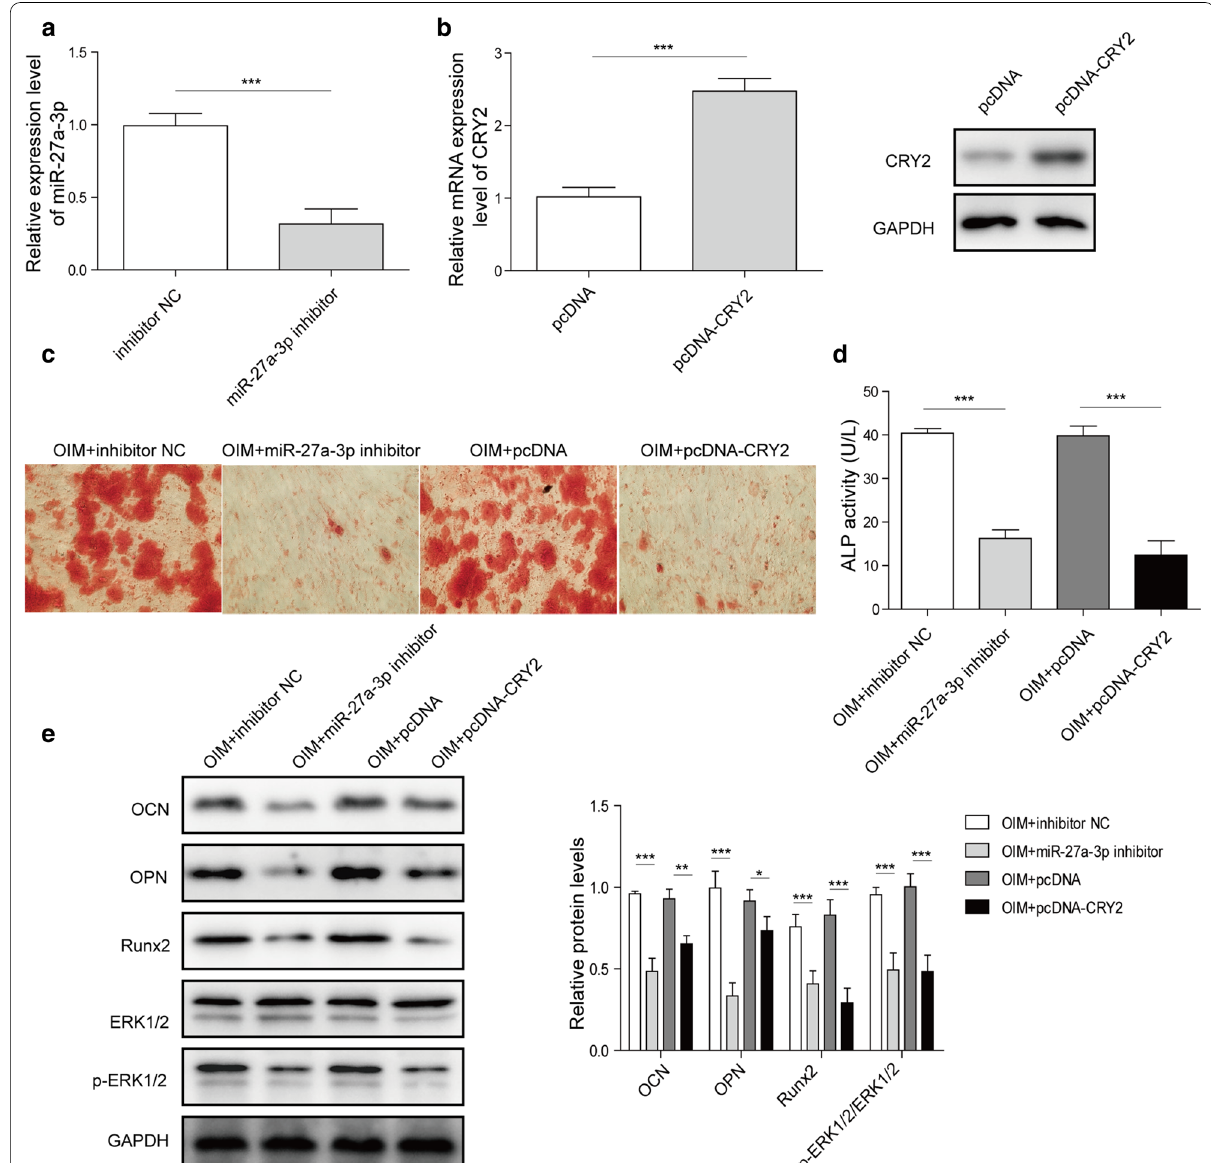
Fig. 2 Knockdown of miR‑27a‑3p and overexpression of CRY2 inhibited ODM. MC3T3‑E1 cells were transfected with miR‑27a‑3p inhibitor or CRY2 overexpression. a RT‑qPCR detected the levels of miR‑27a‑3p. b RT‑qPCR and western blotting examined CRY2 expression. c Alizarin Red staining in MC3T3‑E1 cells. d Detection of ALP activity. e Western blotting analyzed the expression of OCN, OPN and RUNX2. *P < 0.05, **P < 0.01, ***P <